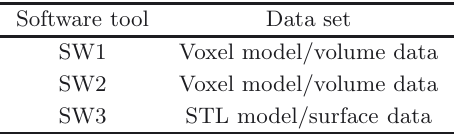
Table 1. An overview of software packages for measurements on volume/surface